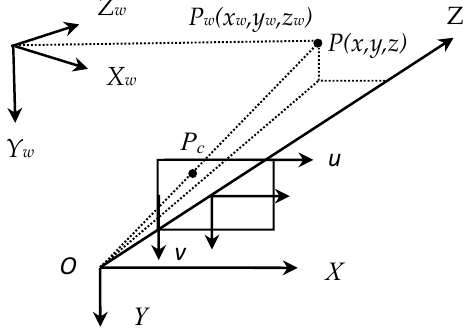
Figure 3. Schematic of the pinhole camera model.